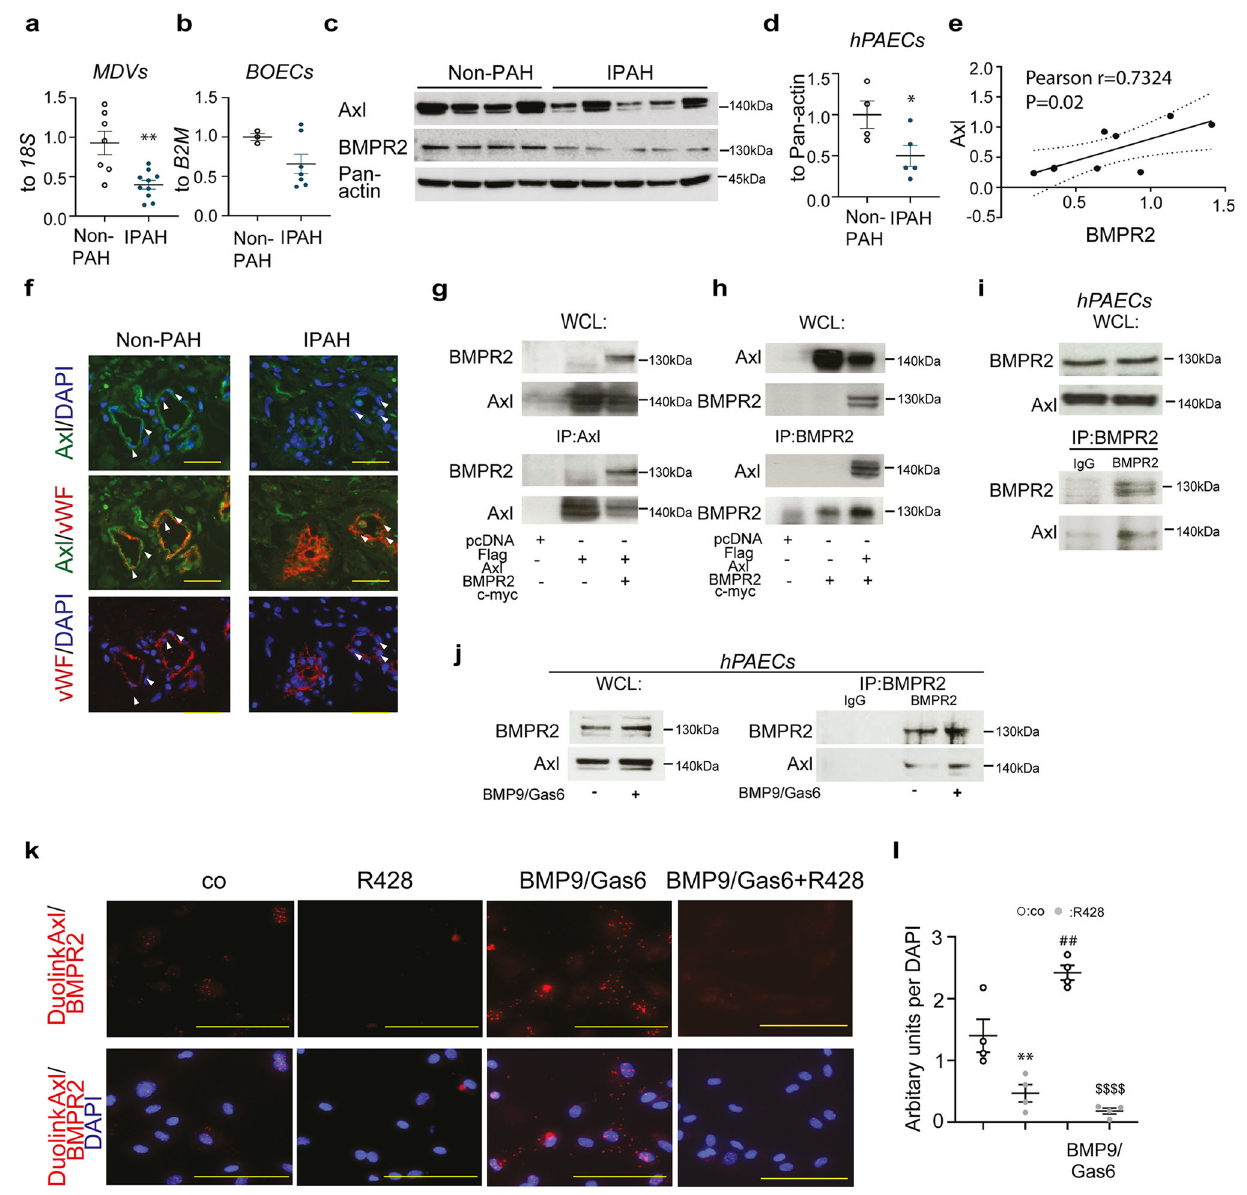
Fig. 9 Axl closely associates with bone morphogenetic protein receptor 2 (BMPR2). a Real-time quantitative PCR analyses of AXL mRNA expression normalized to 18S in laser-assisted microdissected vessels (MDVs) from non-PAH biological independent controls ( n = 7) and patients with IPAH ( n = 10). b Real-time quantitative PCR analyses of AXL expression in mRNA from BOECs of non-PAH biological independent controls ( n = 3) and patients with IPAH ( n = 7), normalized to β 2-microglobulin ( B2M ). c Western blot analysis and d subsequent densitometric quanti fi cation of Axl expression in human pulmonary arterial endothelial cells (hPAECs), isolated from biological independent patients with IPAH ( n = 5) and non-PAH controls ( n = 4). Pan-actin served as a loading control. e Analysis of the correlation between BMPR2 and Axl expression in hPAECs from patients with IPAH ( n = 5) and non-PAH ( n = 4) controls. Pearson correlation coef fi cient ( r value) and the signi fi cance ( P value) of correlation analysis is represented on the graph. ** P < 0.01, * P < 0.5 versus non-PAH control (co). For statistical analyses Student ’ s t -test and correlation analyses were applied. f Representative examples of immuno fl uorescence staining of Axl (green) expression in tissue sections of non-PAH ( n = 4) and IPAH ( n = 4) human lung specimens. Sections were double stained with von Willebrand factor (vWF) (red) antibody. White arrowheads depict the expression of Axl in PAECs. Nuclei were visualized using 4 ′ ,6 ′ -diamidino-2-phenylindole (DAPI; blue). Scale bars: 50 µ m. g , h In HEK293 cells overexpressing Flag-Axl and BMPR2-Myc, g co-immunoprecipitation using Flag antibody to target Axl protein pulled down BMPR2 protein, and h co-immunoprecipitation using BMPR2 antibody pulled down Axl protein. Representative pictures of three independent experiments are shown. i Co-immunoprecipitat i on using BMPR2 antibody pulled down endogenous Axl in hPAECs j co-immunoprecipitations after 48 h of hPAEC stimulation with BMP9/Gas6. WCL = whole-cell lysate; IP = immunoprecipitant. k Representative immuno fl uorescent images and l quanti fi cation of interaction between BMPR2 and Axl by Proximity Ligation (PLA) assay in hPAECs treated with R428 followed by BMP9/Gas6 stimulation. PLA shows close proximity of Axl and BMPR2 in hPAECs. Duolink Axl/BMPR2 = PLA fl uorescence signal; Duolink Axl/BMPR2/DAPI = merged PLA/diamidino-2-phenylindole fl uorescence signals. Scale bars: 50 μ m. Images are representative of four independent experiments. Statistical analyses were performed using one-way ANOVA with Newman-Keuls post hoc test for multiple comparisons. ** P < 0.01 and ## P < 0.001 versus DMSO-treated control (co) cells; $$$$ P < 0.0001 versus BMP9/Gas6 stimulation. All the data represent the mean ±